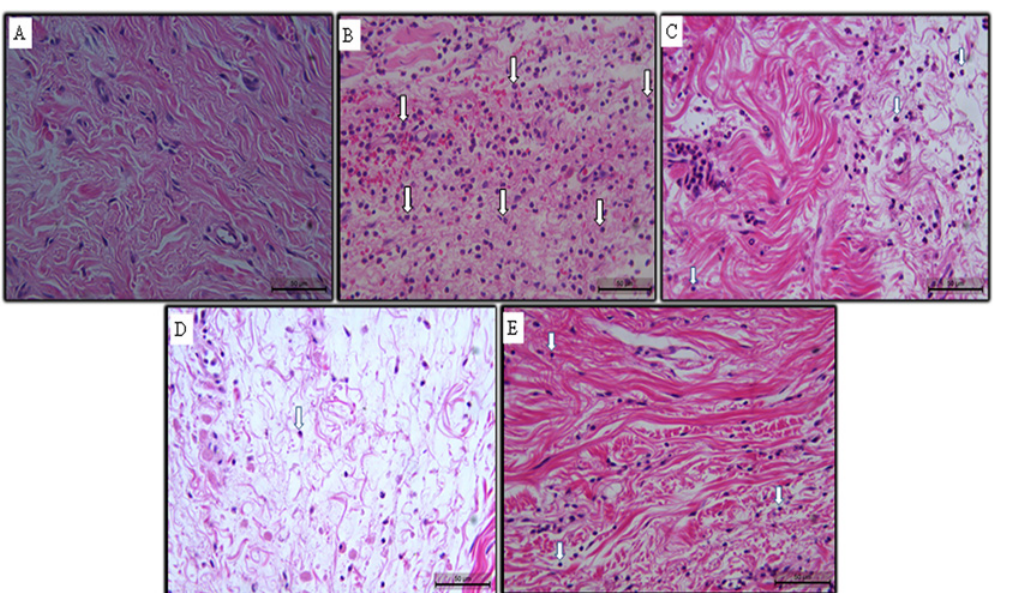
Fig 5. Photomicrographs of the histopathological analysis of paw tissue from rats treated with Gc-FI (3, 9 or 27 mg/kg): (a) saline (b) Cg (c) 3 mg/kg (d) 9 mg/kg (e) 27 mg/kg. White arrows: neutrophils. Scale bar: 50 μ m.